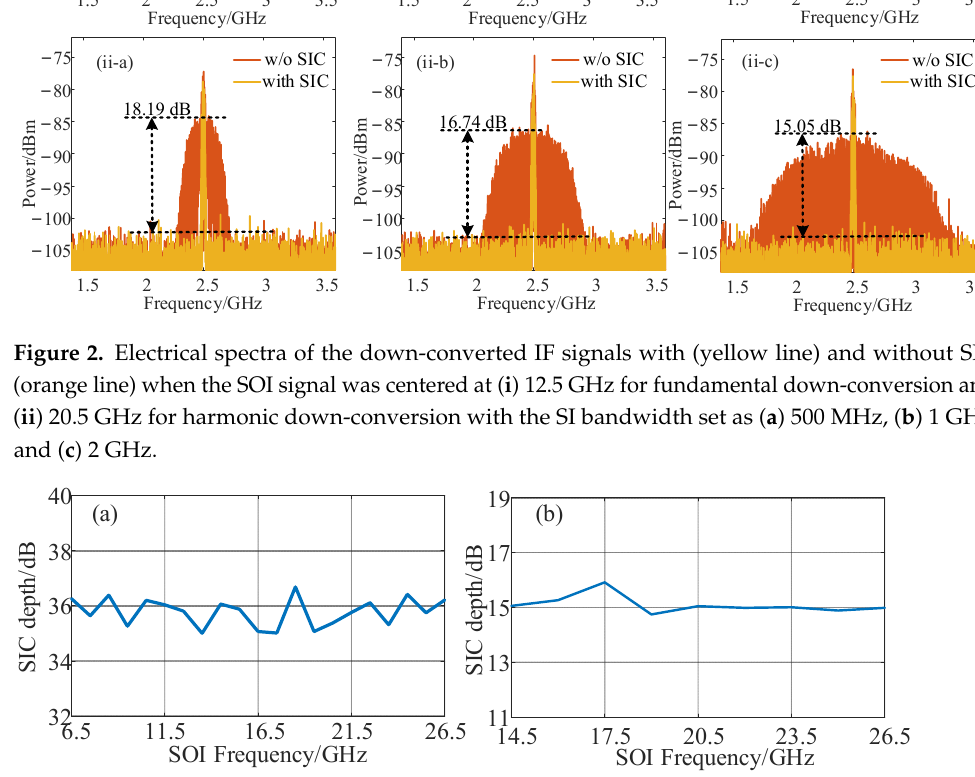
Figure 3. Measure curves of SIC depth versus SOI frequency with SIC enabled when ( a ) fundamental down-conversion and ( b ) harmonic down-conversion were achieved.